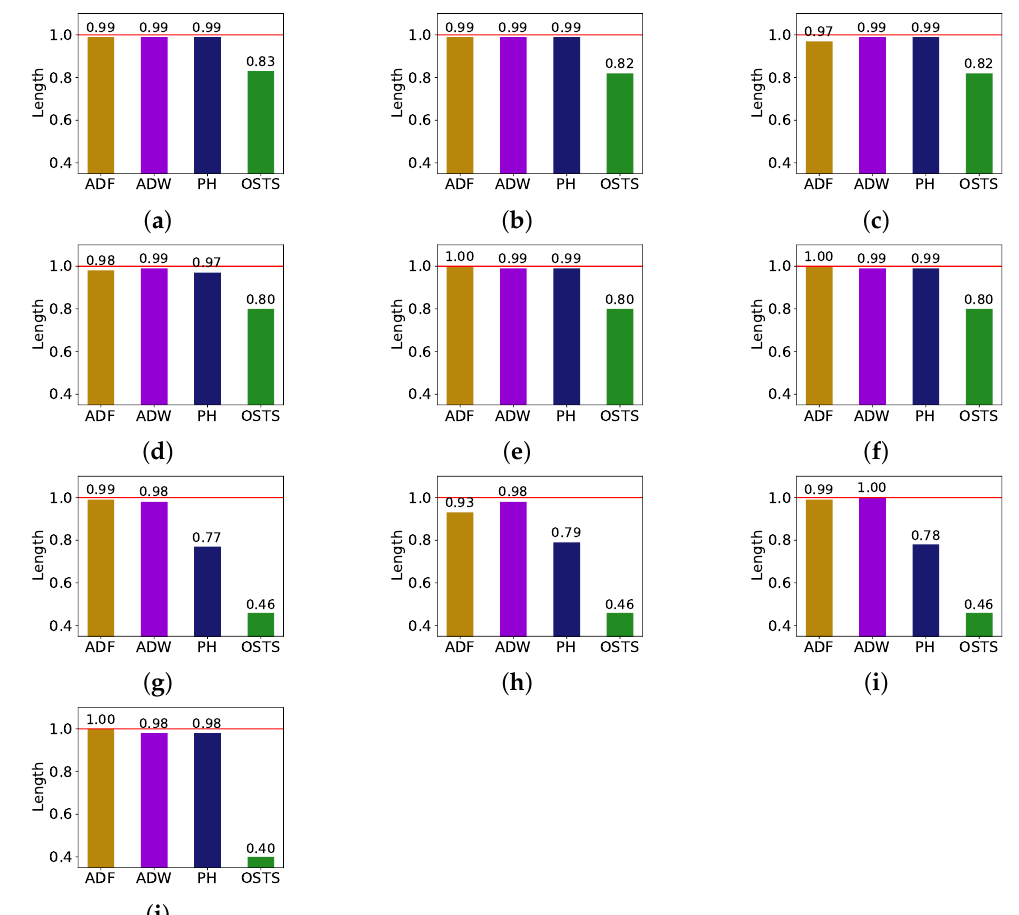
Figure 3. Time series size reduction according to segmentation methods ADF, ADW, PH, and OSTS. ( a ) Database A; ( b ) database B; ( c ) database C; ( d ) database D; ( e ) database E; ( f ) database F; ( g ) database G; ( h ) database H; ( i ) database I; ( j ) database